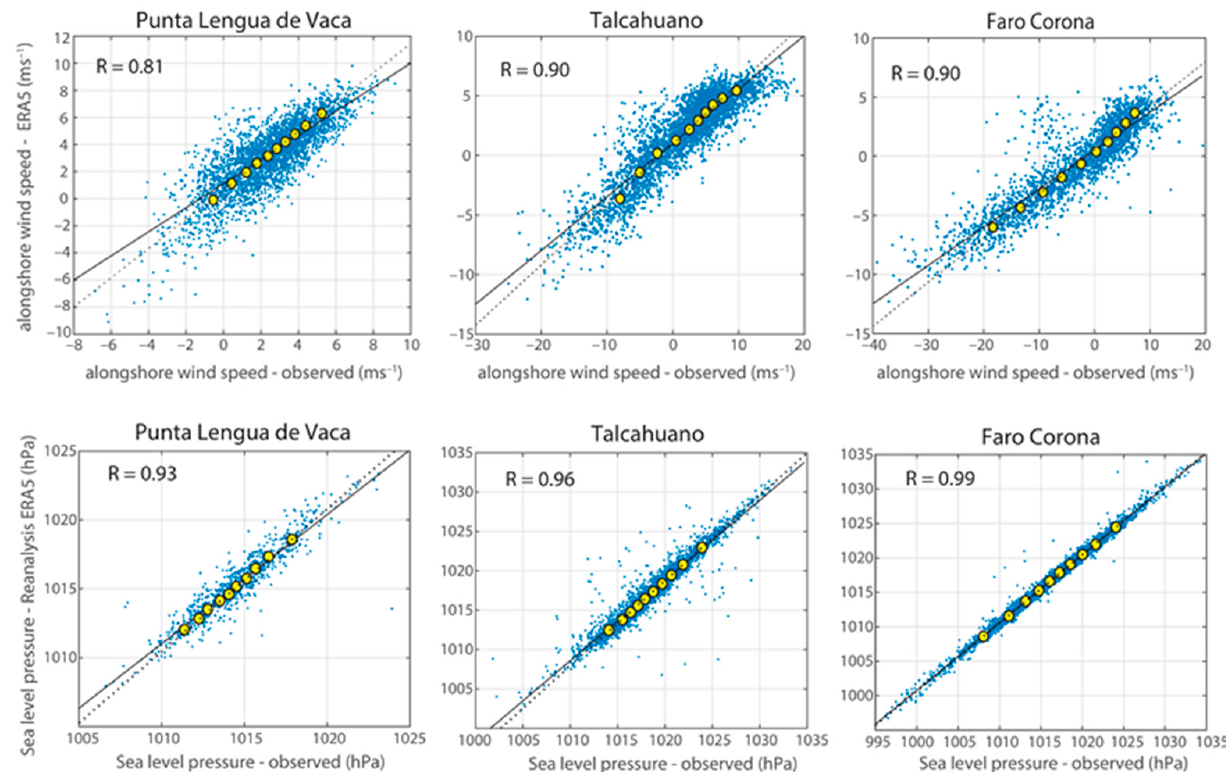
Figure 4. Scatter plots of the observations from meteorological stations and reanalysis data, V a ( upper panel ) and SLP ( bottom panel ).